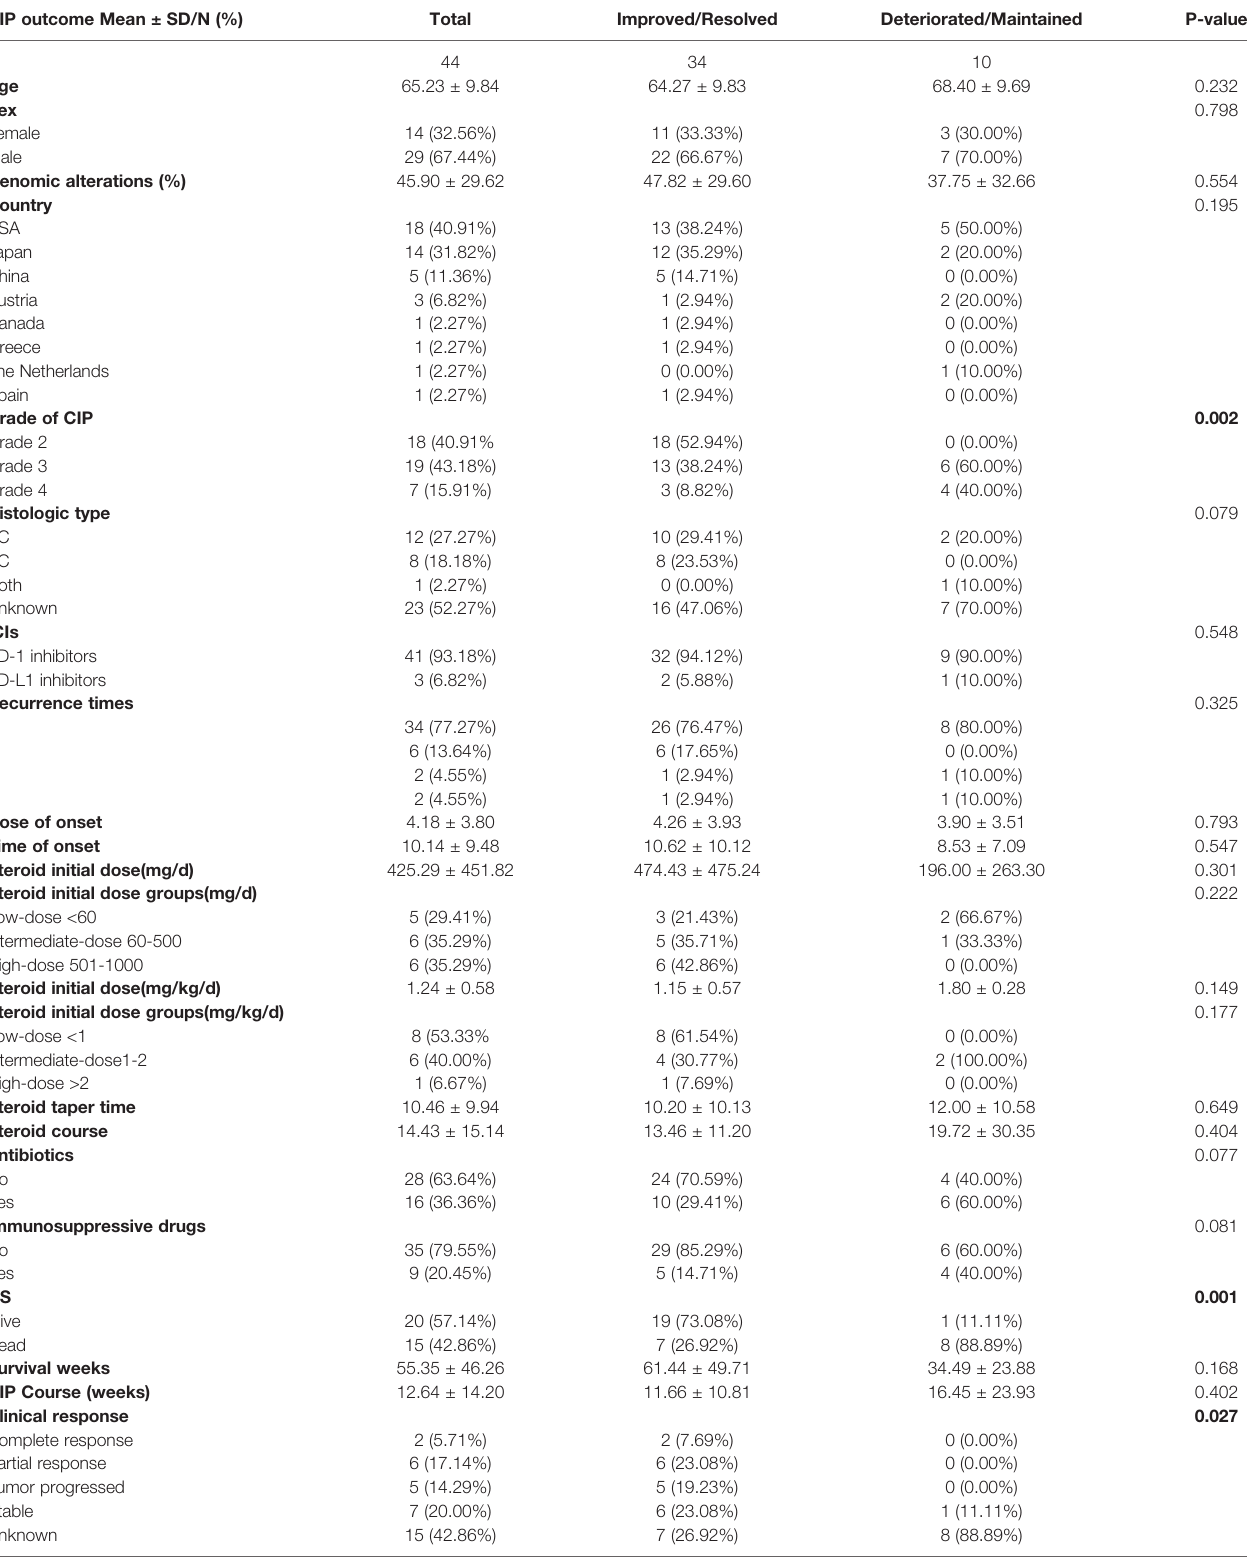
TABLE 2 | Baseline characteristics of the NSCLC cases with CIP according to the CIP outcome. CIP outcome Mean ± SD/N